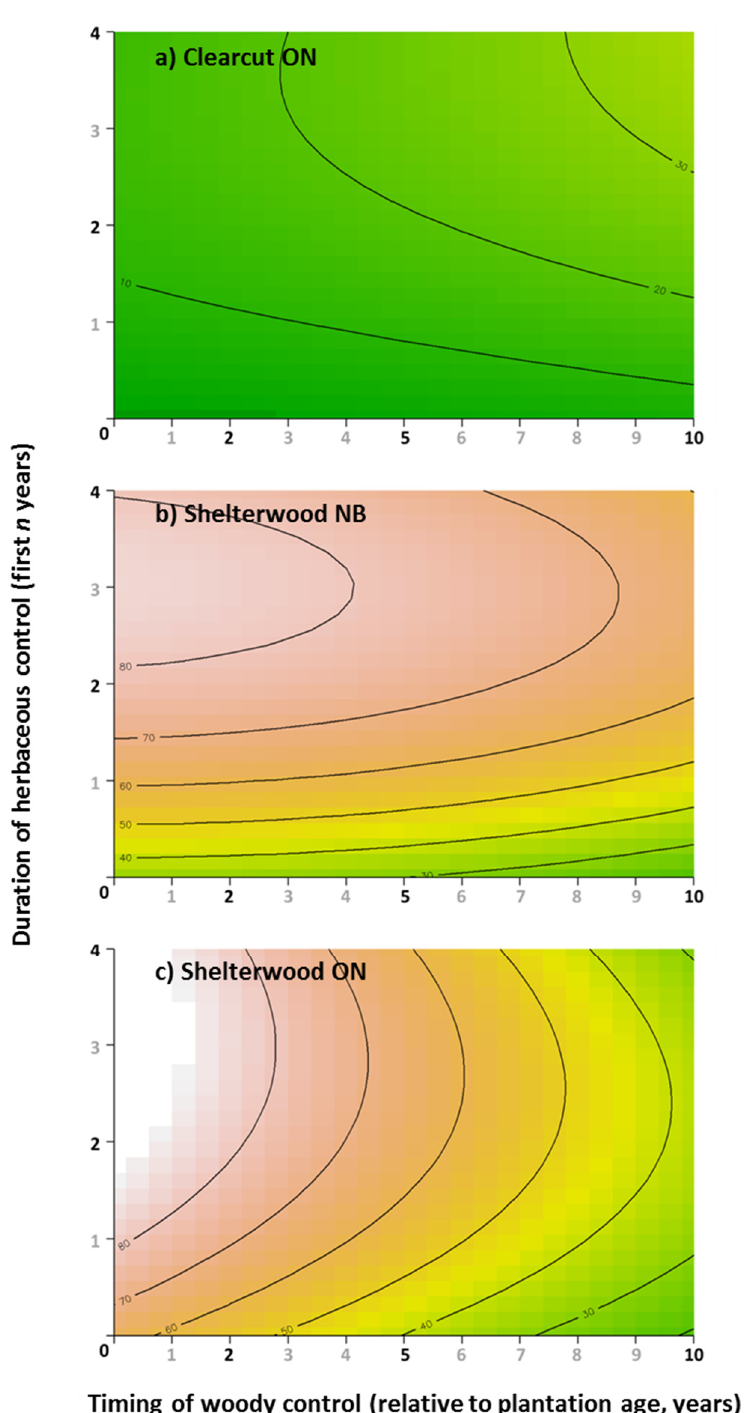
Figure 4. Two-dimensional representations (contour plots) of the response surfaces for age-10 planted pine P250 (percentage of trees meeting or exceeding an age-10 height target of 250 cm) for the clearcut ( a ) and shelterwood NB ( b ) and ON ( c ) sites ( n = 60 observations for each). Colour tones move from highest (white) to lowest (green) P250. See Table 2 for model statistics.